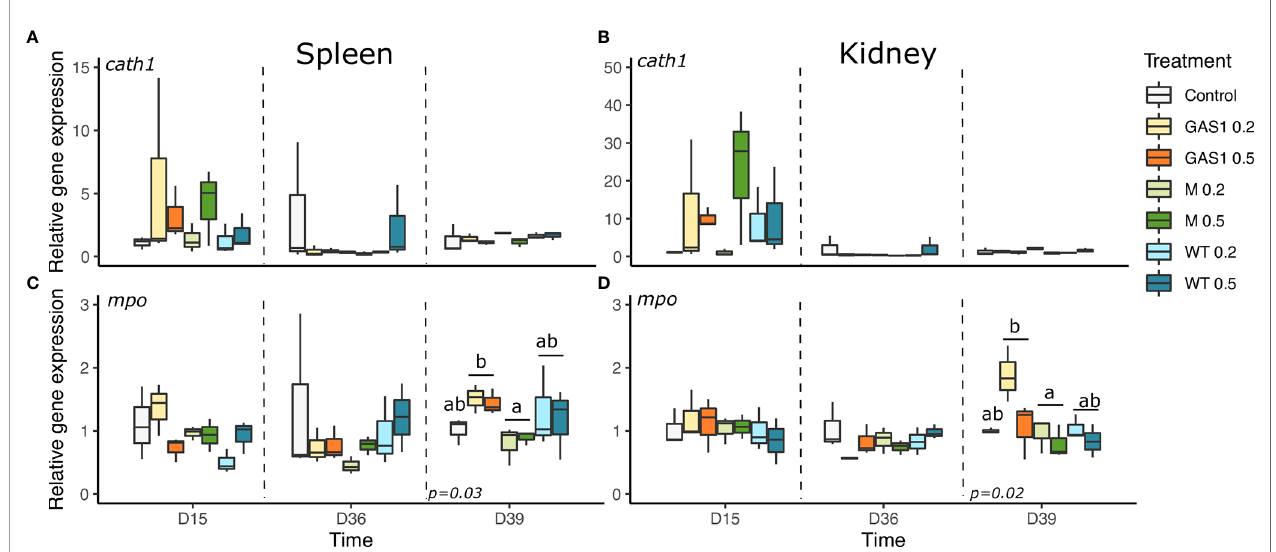
FIGURE 7 | Effects of dietary beta glucans on Cathelicidin and Myeloperoxidase ( MPO ) genes expression in spleen or kidney of fi sh sampled during the nutrient test on D15 and D36, or 2 days after the bacterial challenge (D39). (A) CATH1 gene expression in spleen. (B) CATH1 gene expression in kidney. (C) MPO gene expression in spleen. (D) MPO gene expression in kidney. Relative transcript (mRNA) levels were determined by real-time RT-PCR and normalized by the arithmetic mean of ef-1 a gene expressions. Values are expressed as mean ± SD of 3 pool samples per experimental condition (3 fi sh per pool sample). Statistical differences, highlighted by letters, are indicated for glucan concentrations in front of 0%, 0.2%, and 0.5% next to the corresponding plot, for glucan type by letter above the horizontal bar grouping the two doses of the same glucan, for glucan type × concentrations interactions above each box. P values are shown at the bottom of each graph at a given time point (D15, D36, or